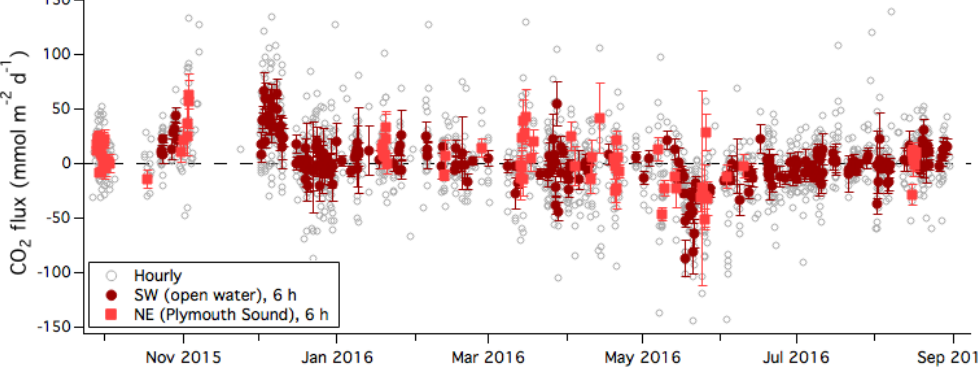
Figure 4. One-year time series of CO 2 flux (hourly average) during times when winds were from the sea. Six-hour averages are further separated into the southwest (open water) and northeast (Plymouth Sound) wind sectors. Error bars indicate standard error.